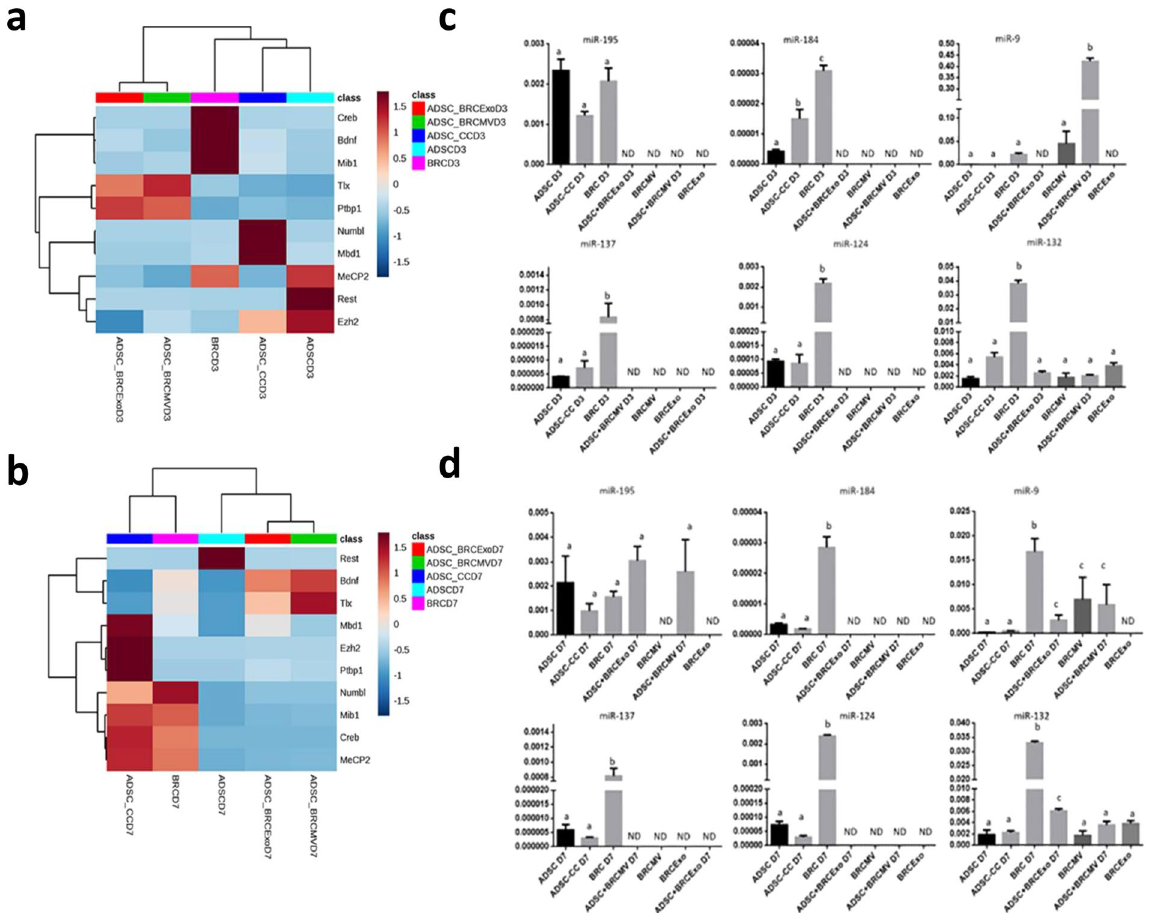
Figure 3. Co-culture and EVs neuronal induction modulating the neurogenic transcript levels. ( a ) Heatmap with hierarchical grouping and analysis of the main genes related with the neurogenesis, showing the differences between ADSC induced or not and brain cells on D3. ( b ) Heatmap with hierarchical grouping and analysis of the main genes related with the neurogenesis, showing the ADSC-CC D7 as the most similar to BRC. ( c ) miRNAs studied in the ADSC induced into neuron-like cells by co-culture or by extracellular vesicles on day 3. There was more expression of miR-184, miR-137, miR-124 and miR-132 in neurons than the other cells types. ADSC-CC showed more expression of miR-184 than the other stem cells, and ADSC + BRCMV D3 showed more expression of miR-9 than the other cells type. ADSC-CC D3 had similar miRNAs levels than ADSC D3, and miR-132 expression was similar in all stem cells. ( d ) miRNAs studied in the ADSC induced into neuron- like cells by co-culture or by extracellular vesicles on day 7. There was more expression of miR-195, miR-184, miR-137, miR-124 and miR-132 in BRC than the other groups. Different letters of the same graph indicate statically difference between the groups. (p ≤ 0.05). ND- no